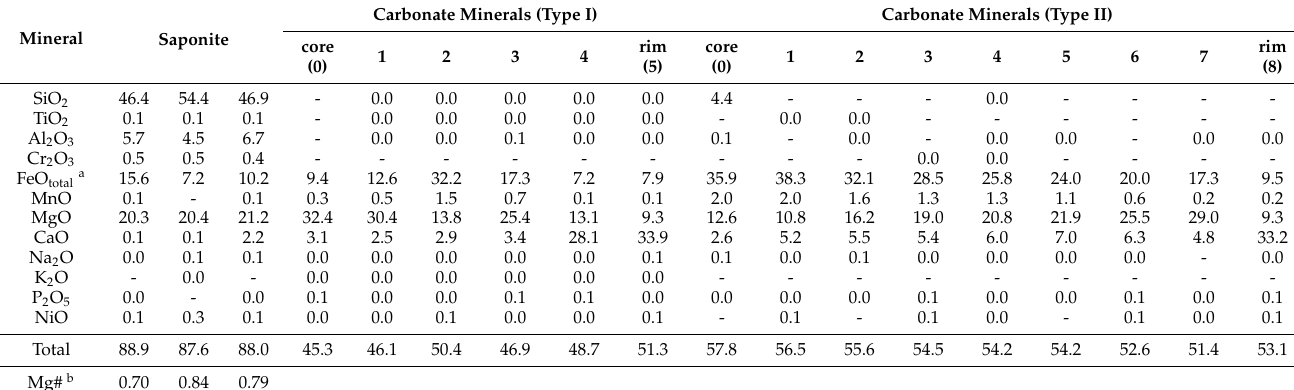
Table 5. Representative compositions of minerals (wt.%) in Exp-K as determined using